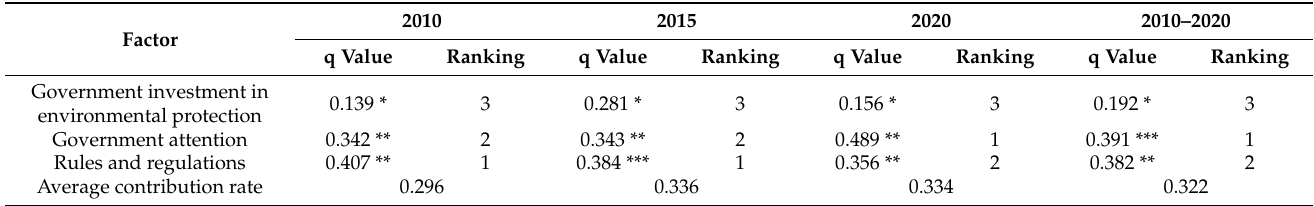
Table 3. Detection results of global ER drivers.